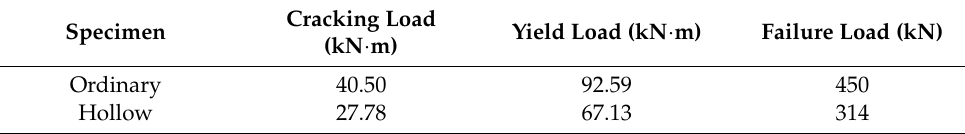
Figure 9. Load–displacement curve of the test. Figure 9. Load – displacement curve of the test. Figure 9. Load – displacement curve of the test. Table 2. Test load results. Table 2. Test load results. Table 2. Test load results.